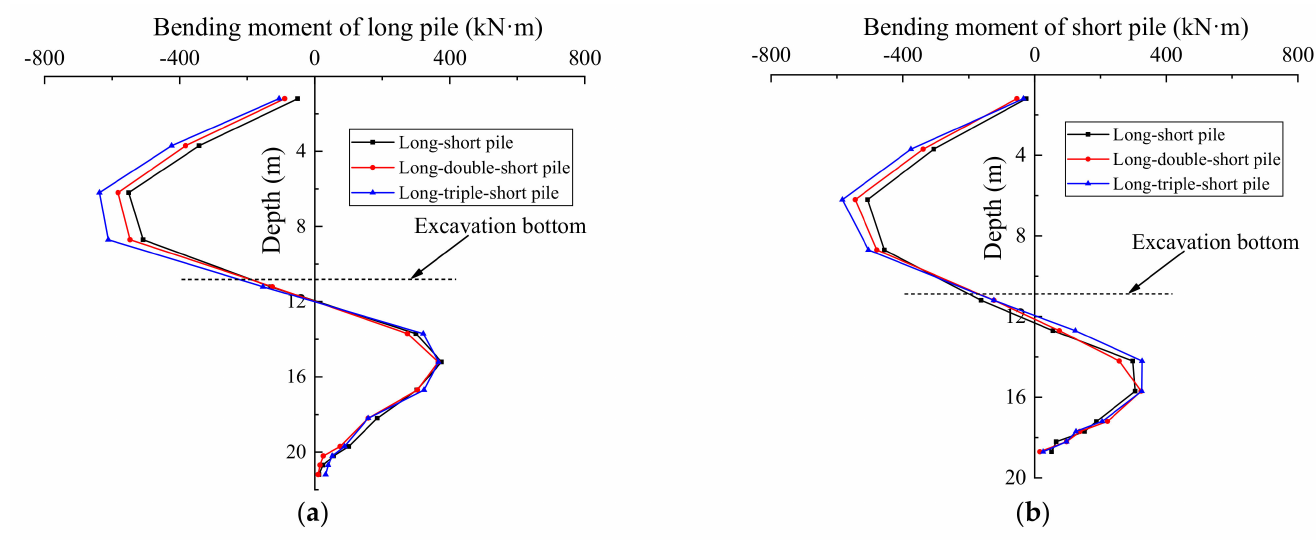
Figure 8. Bending moment of the pile after excavation to 10.85 m: ( a ) long pile; ( b ) short